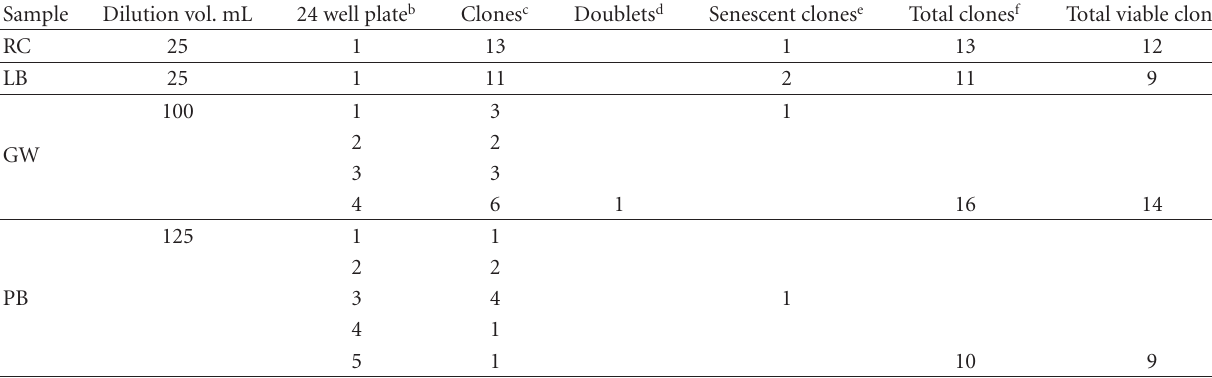
Table 1: Independent cell populations from uncultured amniocentesis samples a